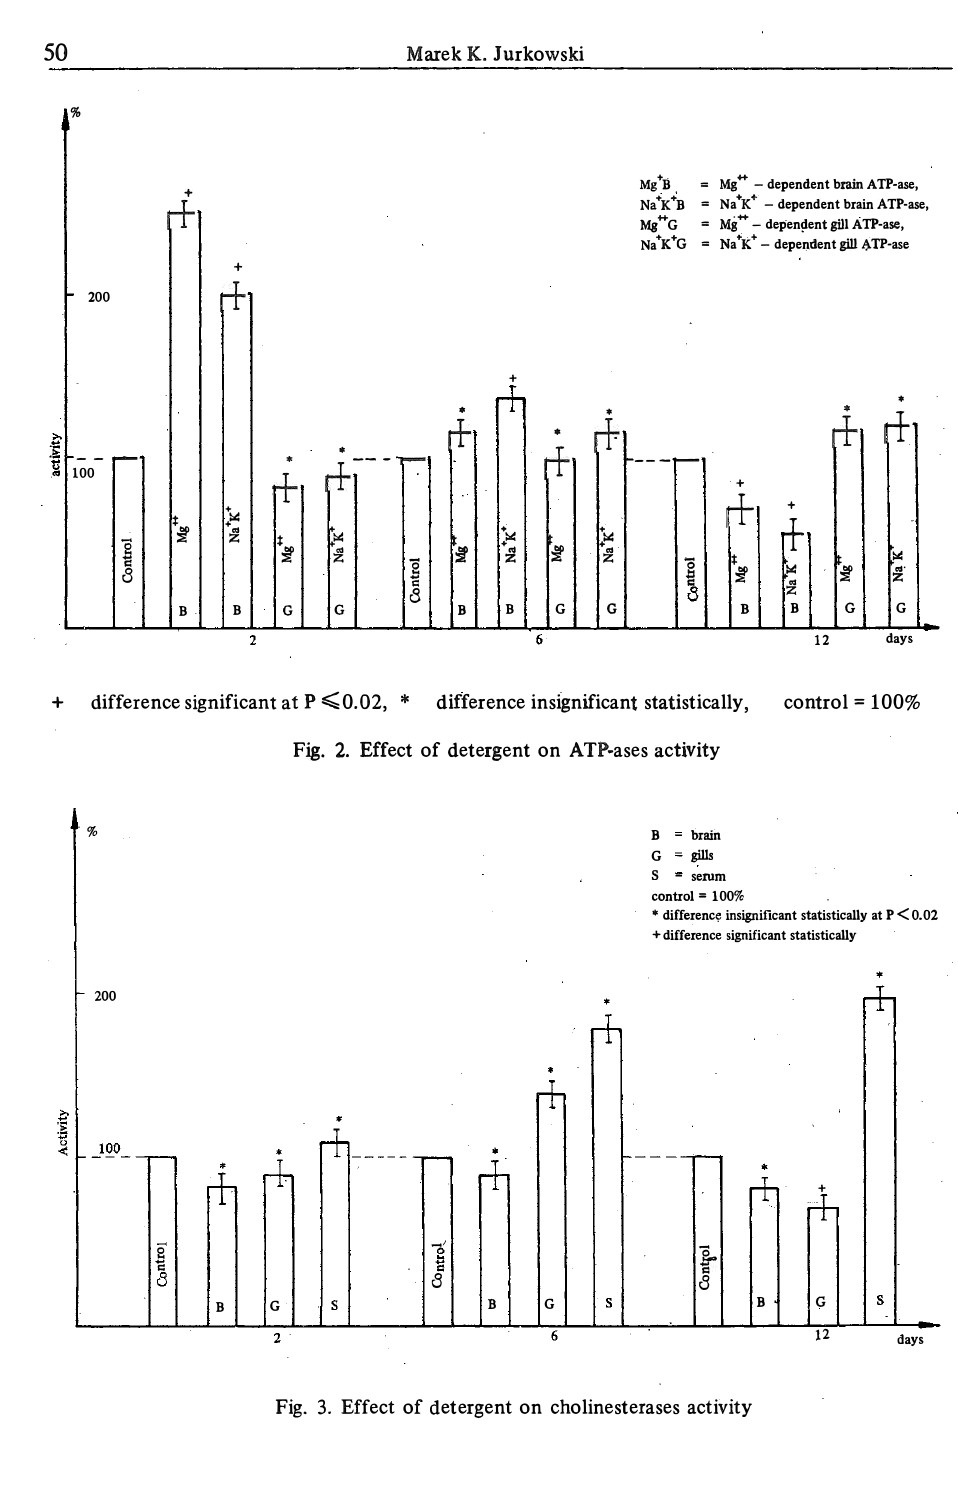
Fig. 3. Effect of detergent on cholinesterases